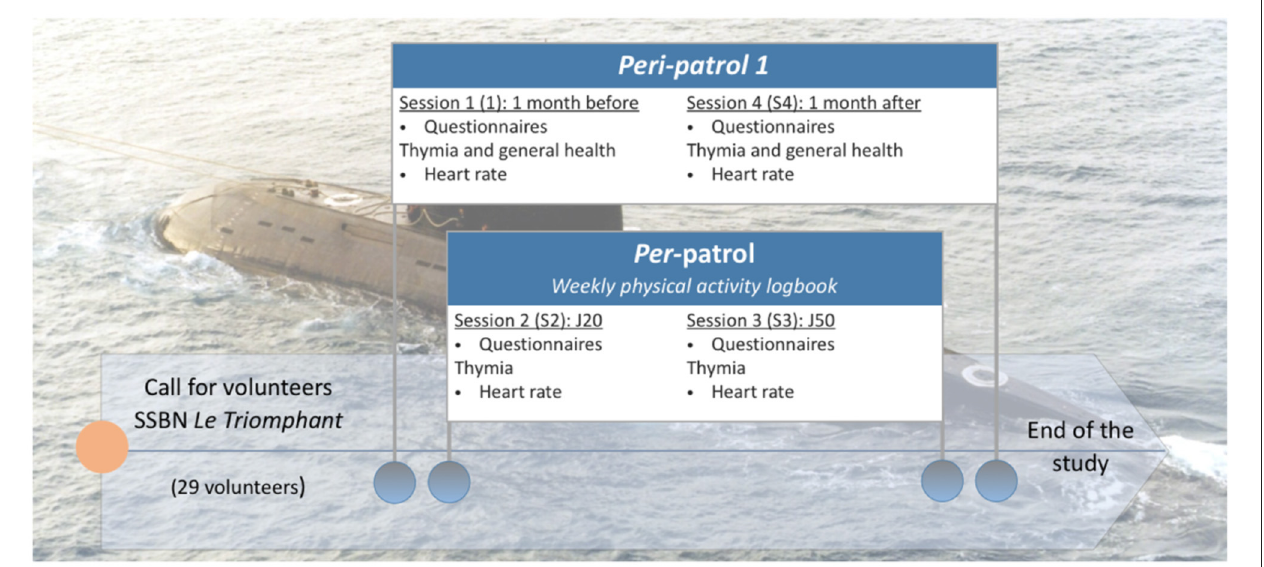
FIGURE 1 | Proposed experimental design according to operational constraints. The indiced collection times, day 10 and day 50, are approximations.